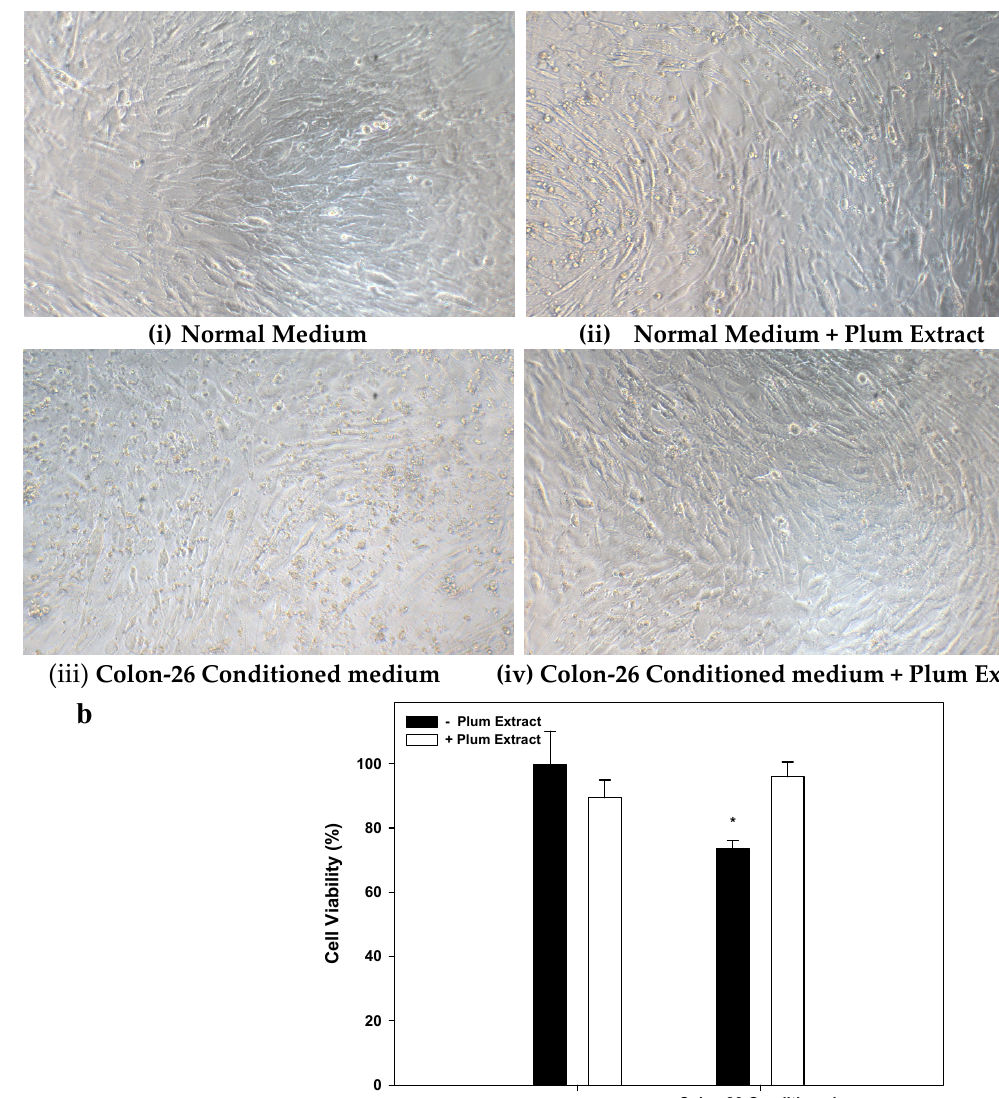
Figure 7. Effect of plum extract on Colon-26 adenocarcinoma cells. Data were calculated as % inhibition of cell growth in response to various concentrations of plum extract. The data are expressed as mean ± SD for at least three replicates. All comparisons were made to control (untreated cells) using one-way ANOVA; the significant differences are reported at * p < 0.05. 3.8. Effect of PE60 Plum Extract on C2C12 Cell Viability in Response to Colon-26 Cells Cytotoxicity-Inducing